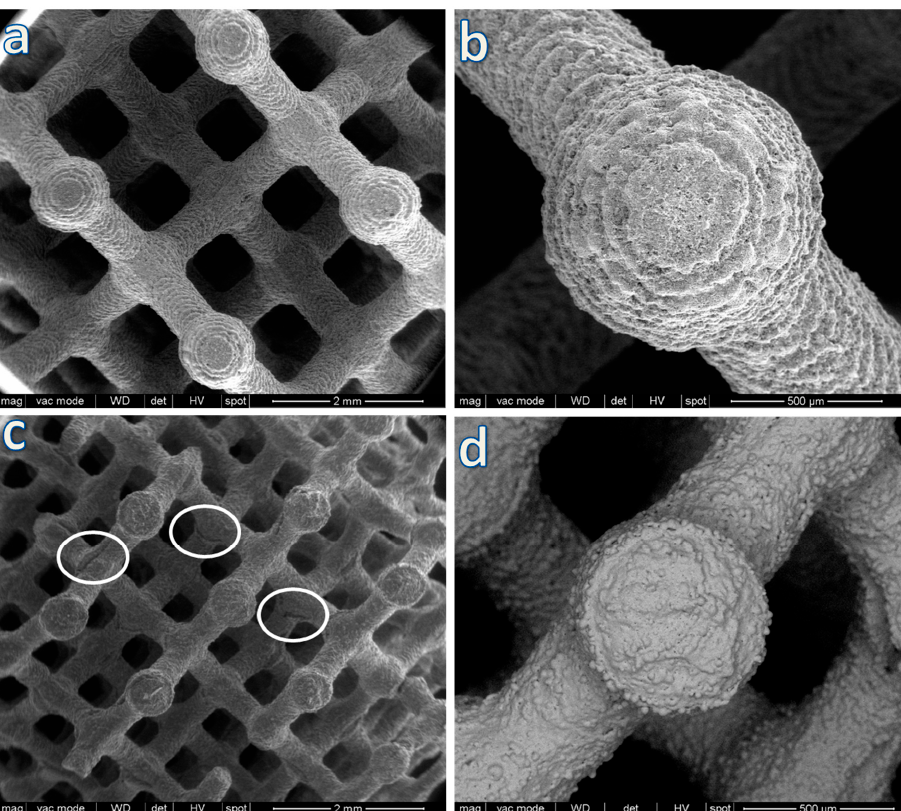
Figure 1. Microstructural details of a scaffold with diamond cell design after printing; ( a,b ) before firing and ( c,d ) after firing at 750 °C.